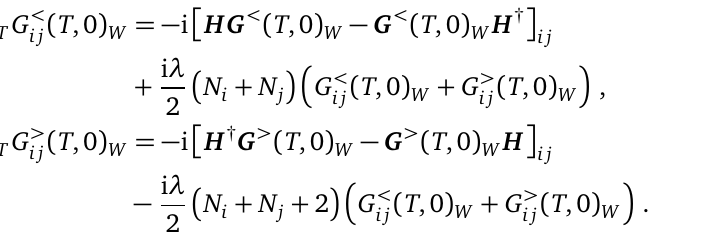
Figure 14: Evolution of the site occupations 〈 ˆ a † spectral function − Im A ω = 2.5 λ , ω 1 ( 0,0 ) = − 2i δ G < ij and rtol=1e-4 .